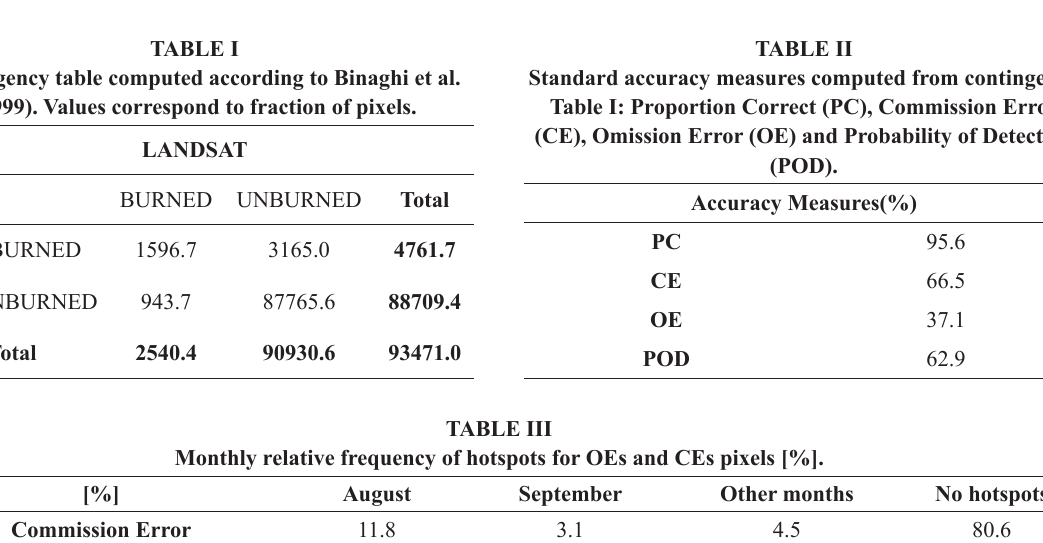
Figure 6 - Spatial distribution of PODs (green pixels), CEs (red pixels) and OEs (blue pixels). Right panel (b) shows a zoom of the area delimited by the black rectangle (a) . The area inside the black circle (b) shows the largest scar not detected by the